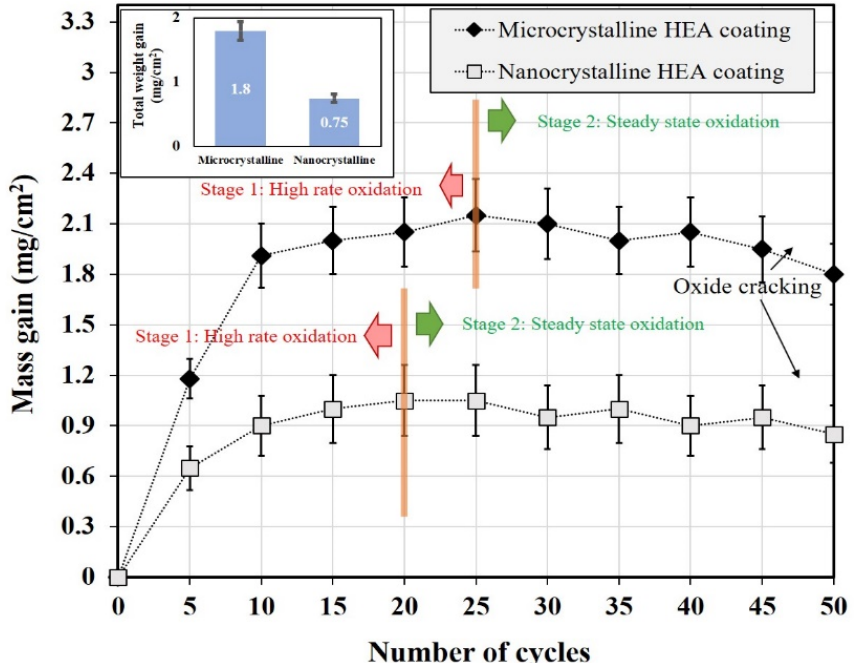
Figure 8. The plot of weight gain/area vs. the number of cycles for micro- and nanocrystalline AlCrFeCoNi HEA coatings subjected to cyclic oxidation at 1100 °C.